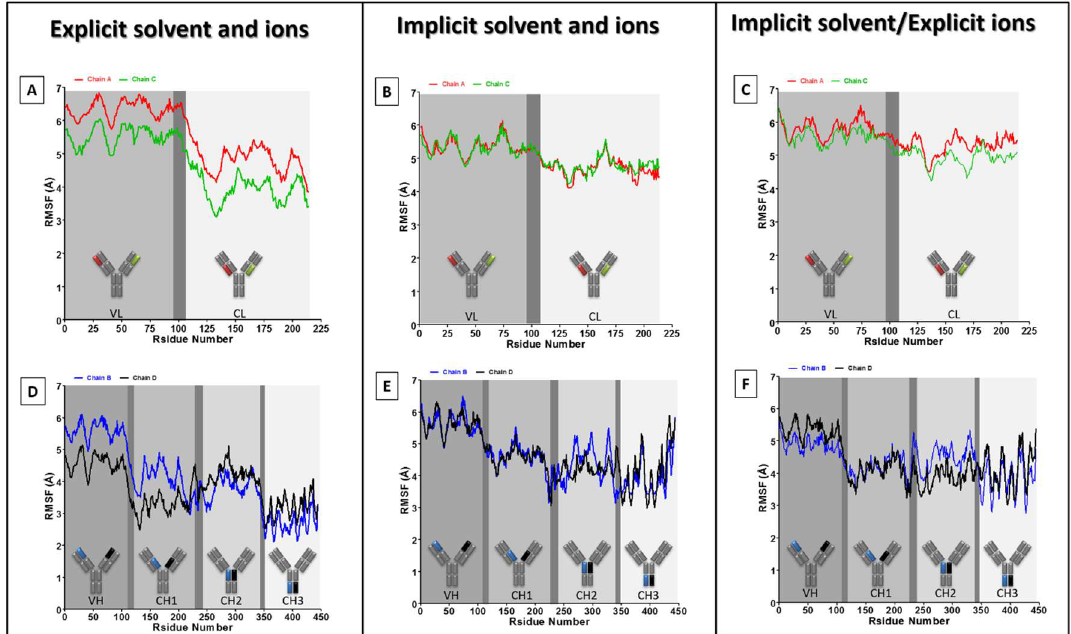
Figure 5. RMSF analysis of the four antibody chains. RMSF values plotted for each residue for the two light ( A – C ) and two heavy ( D – F ) chains. Each domain is depicted on the RMSF figures, separated by dark grey regions that represent the linkers. The inset schemes indicate the analyzed fragment location in the antibody 3D